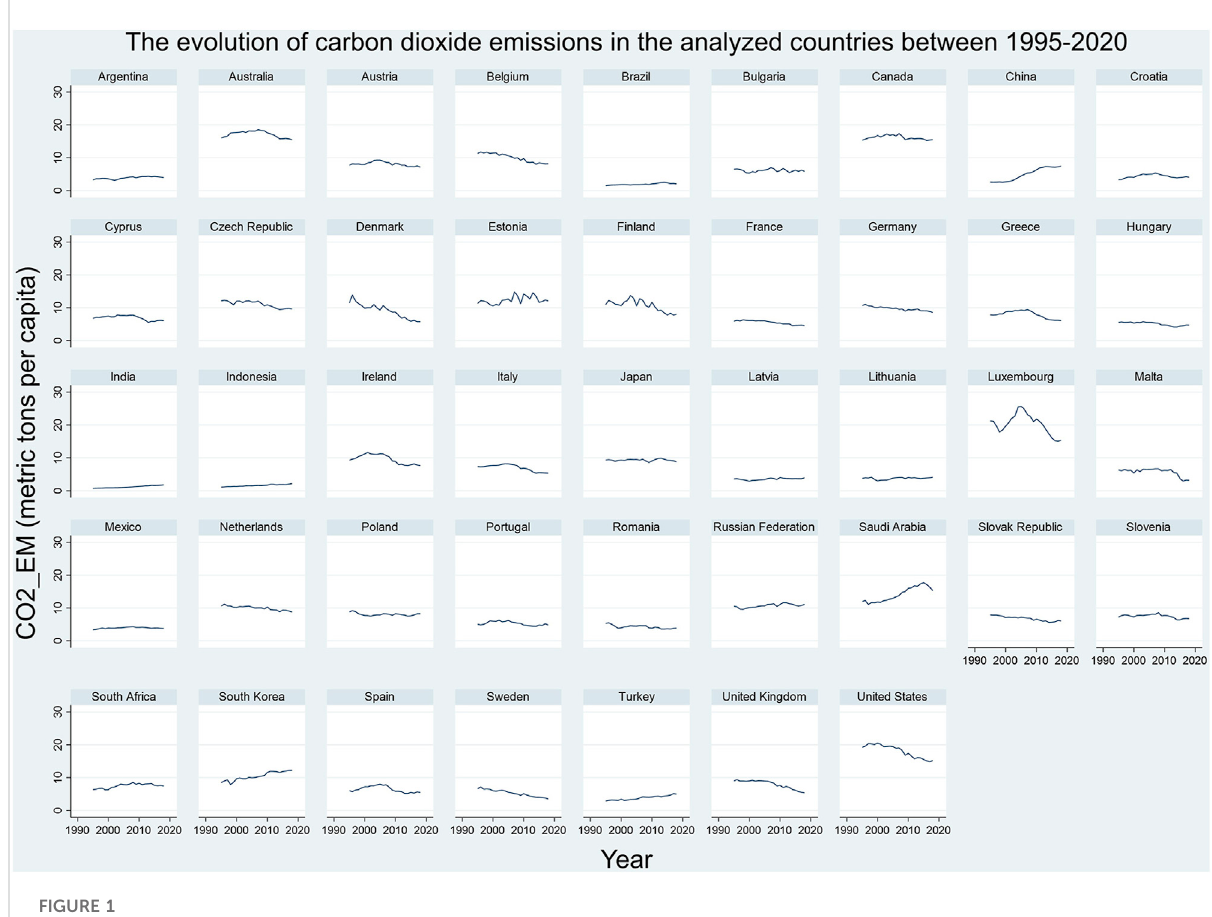
FIGURE 1 Representation of panel data- CO2 emissions by countries for the period